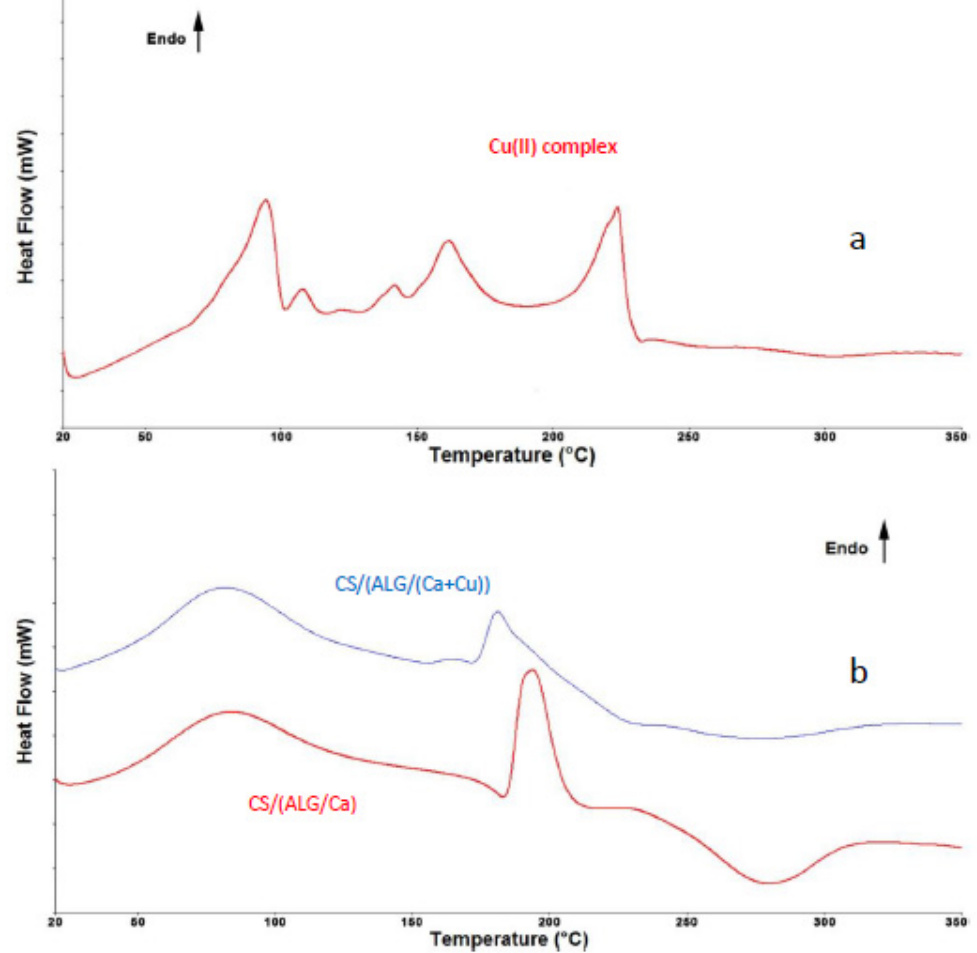
Figure 6. DSC thermograms of ( a ) Cu(II) complex and ( b ) CS/(ALG/Ca) and CS/(ALG/(Ca+Cu)) microcapsules determined under N 2 flow. Table 4. Peak transition temperatures (T peak ) and enthalpy change ( Δ H) of Cu(II) complex and